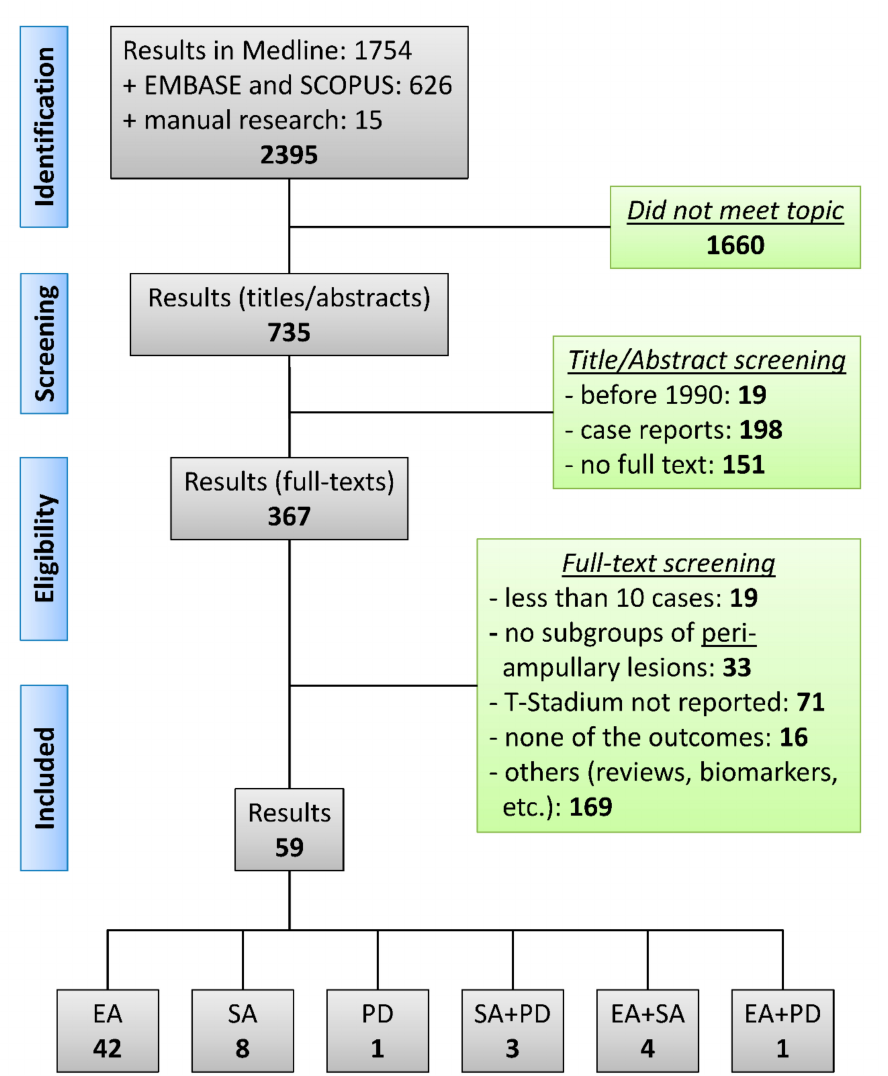
Figure 1. Flowchartofthestudyselectionprocess.Outof2395searchresults,59paperswerefinallyincluded in the analysis. EA: endoscopic ampullectomy, SA: surgical ampullectomy, PD: